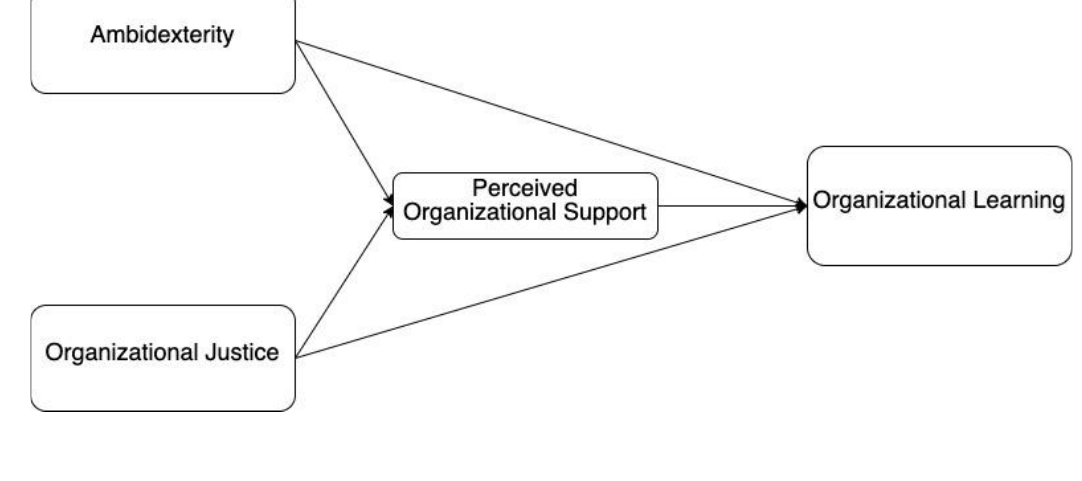
Figure 1: Model of the